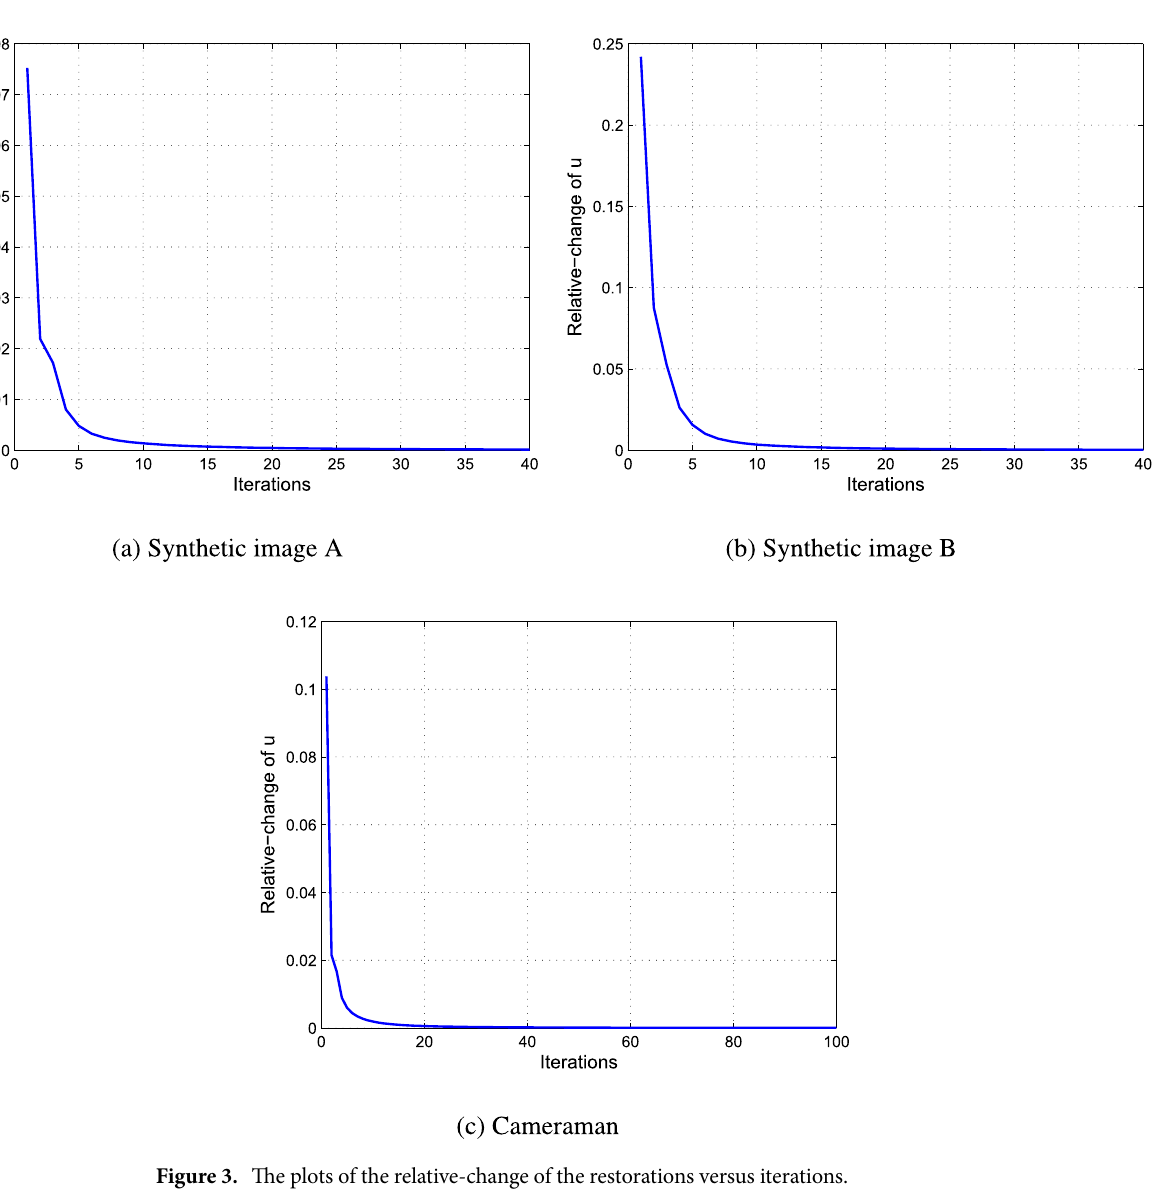
Figure 3. The plots of the relative-change of the restorations versus